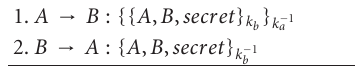
Table 2: Exemple of deacreasing